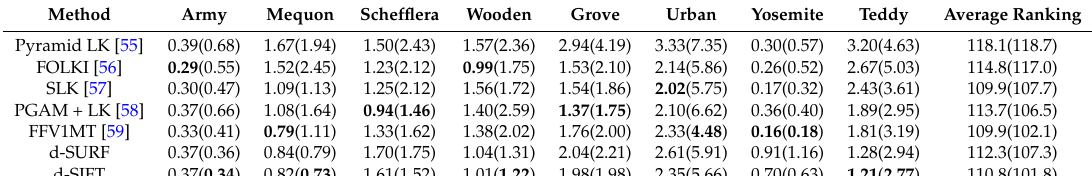
Table 6. Average (standard deviation) of endpoint error comparisons for the Middlebury test dataset. Method